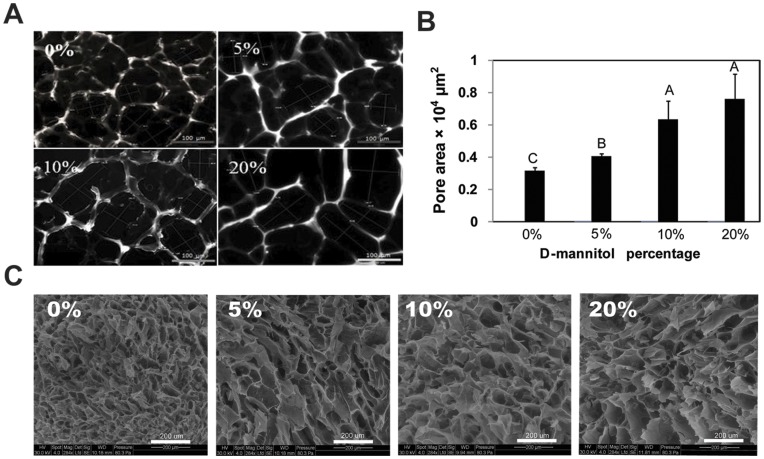
Pore size analysis of MAC scaffolds.(A) Microscope images of acellular MAC scaffolds with varying mass percentages of D-mannitol. (B) Pore sizes of MAC scaffolds with varied D-mannitol percentages. Letters denote significance by single factor ANOVA with Tukey’s post hoc analysis (p<0.001). (C) SEM images of MAC scaffolds with varying mass percentages of D-mannitol. Freeze-dried scaffolds collapse during the process, so the pore sizes are not directly comparable to those shown in A and B. Mean ± SD with n = 3.